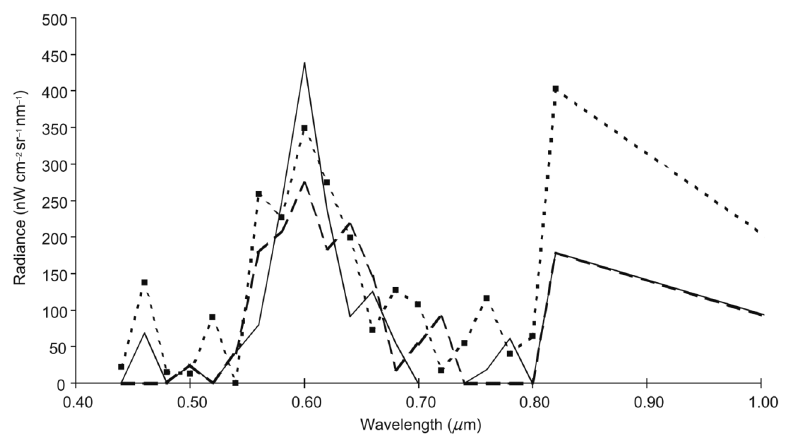
Fig. 5. Visible and near-infrared spectra of three city lights at three different pixels extracted from radio- metrically corrected MIVIS image. The square symbols indicate the wavelength position of the MIVIS chan- nel.